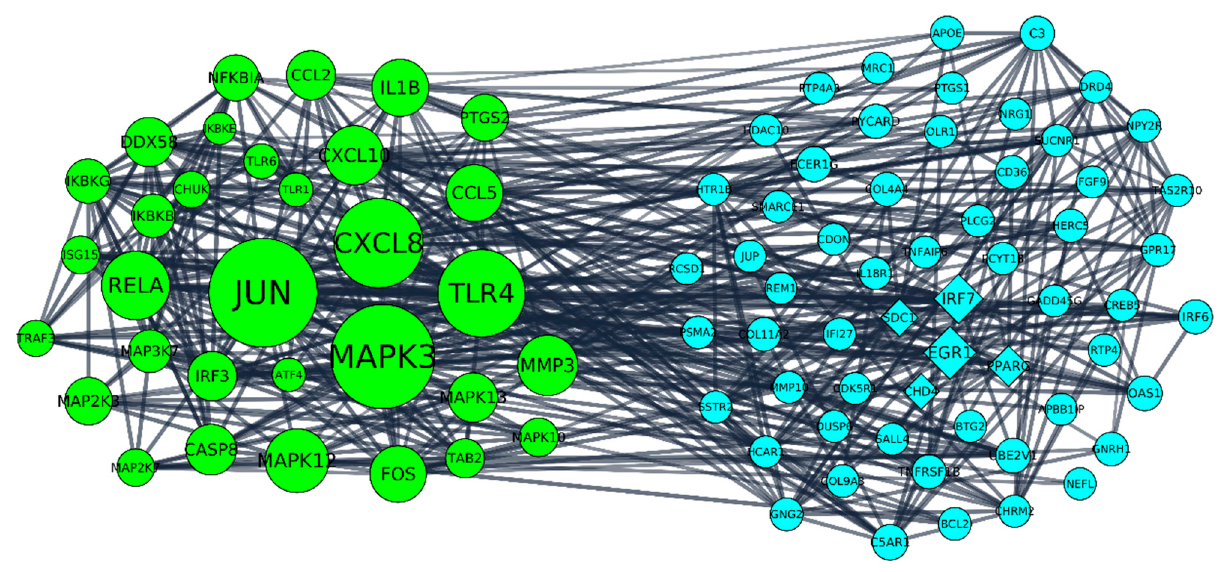
Figure 4. The interactomic analysis was focused on DEGs that have a fold change magnitude higher than 2 (blue DEGs on the right). Nevertheless, we also included in the analysis DEGs that are already known to be associated with immunity response selected on the bases of KEGG analysis even if only some of them have higher fold change differences (green DEGs on the left). The size of the nodes is dependent on the stress parameter so the bigger the node size, the higher the stress of that node in the network. The stress parameter gives an index of the centrality of the node in the network. Among the blue DEGs, EGR1 , IRF7 , PPARG , SDC1 and CHD4 in diamond shape had the five highest stress levels. For this reason, they may have a key role in immunity response to SARS-CoV-2.